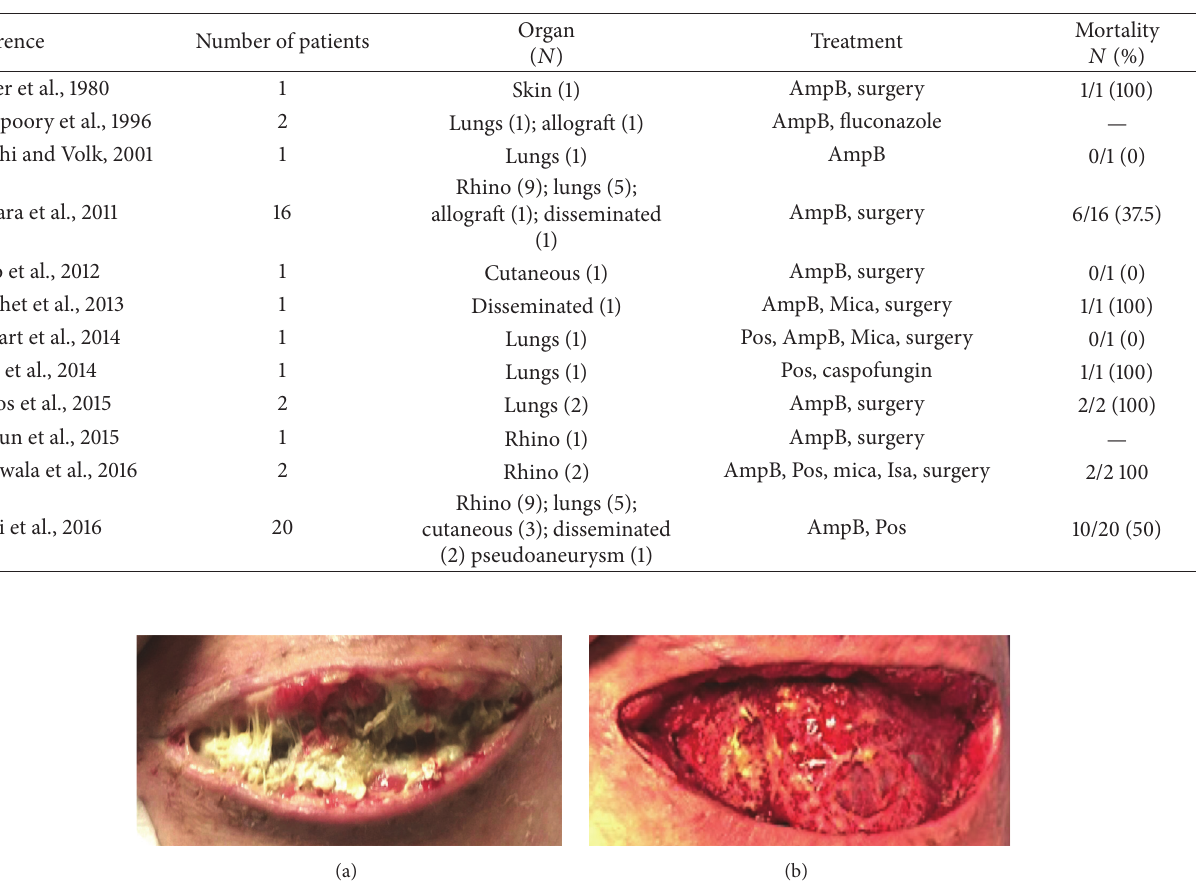
Table 1: Summary of existing publications on mucormycosis in renal transplant recipients.